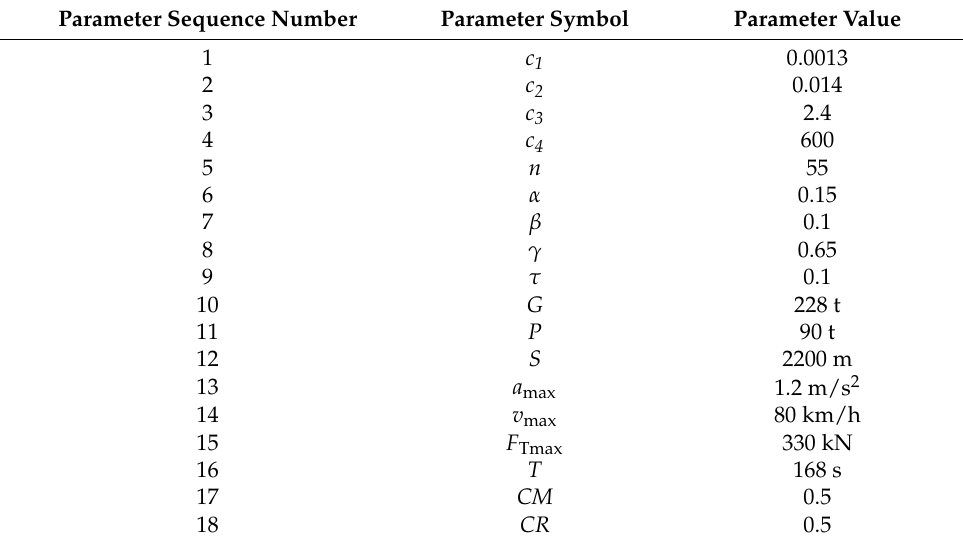
Table 1. Main parameters of the simulation analysis. Parameter Sequence Number Parameter